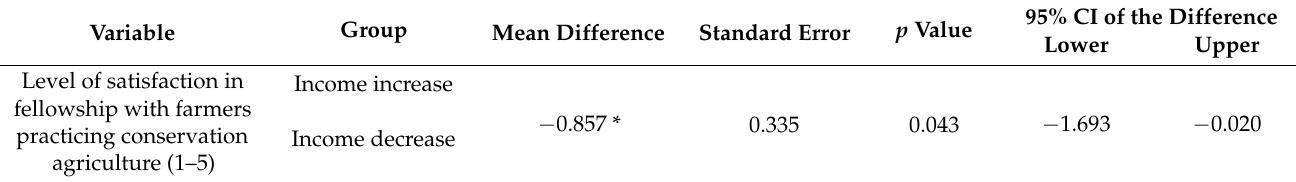
Table 4. Results of multiple comparison procedure with a Bonferroni adjustment.